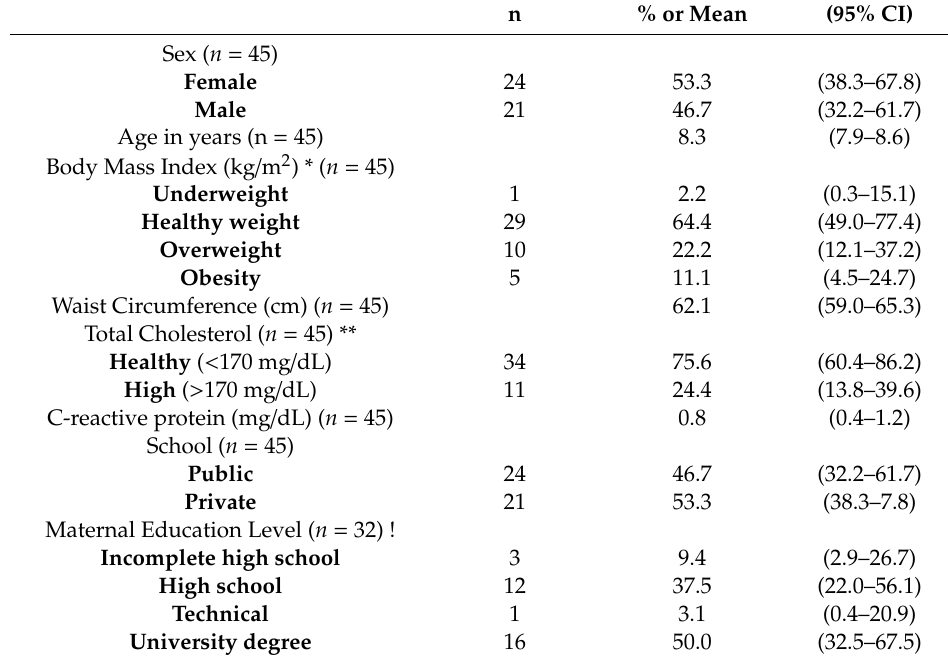
Figure 1. Flow chart of children (6–10 years) participating in the validity of questionnaires ranking fruit and vegetable intake with plasma vitamins. Table 1. Characteristics of the subsample of children (6–10 years) from the SAYCARE (South American Youth/Child Cardiovascular and Environmental) study with plasma vitamins. São Paulo, Brazil. 2017.